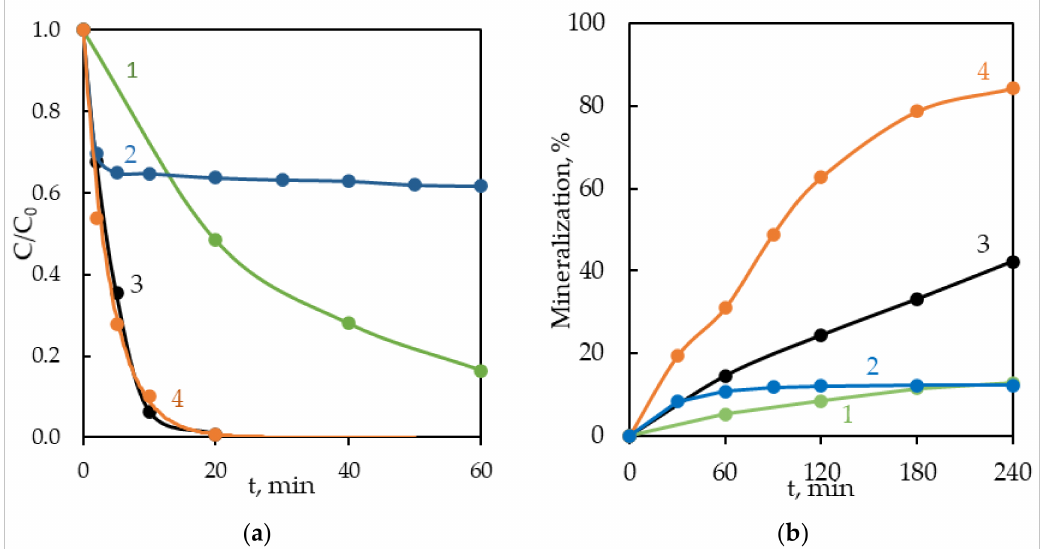
Figure 5. Kinetic curves of BPA degradation ( a ) and mineralization ( b ) in different oxidation systems: UV (curve 1), Fe 2+ /S 2 O 8 2 − (curve 2), UV/S 2 O 8 2 − (curve 3), UV/Fe 2+ /S 2 O 8 2 − (curve 4). [BPA] 0 = 43.8 µ M, [Fe 2 + ] 0 = 71.4 µ M, [S 2 O 82 − ]:[BPA] =